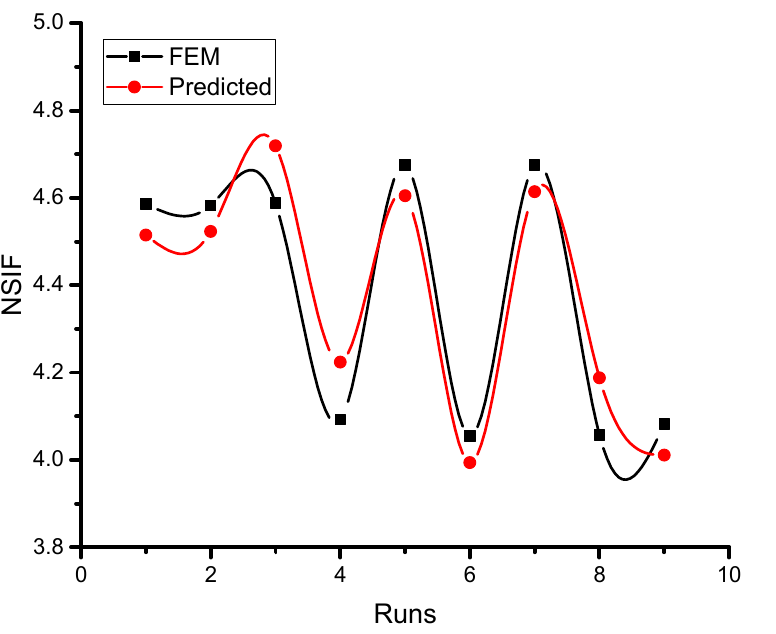
Figure 8. Comparison of FEM and predicted results.